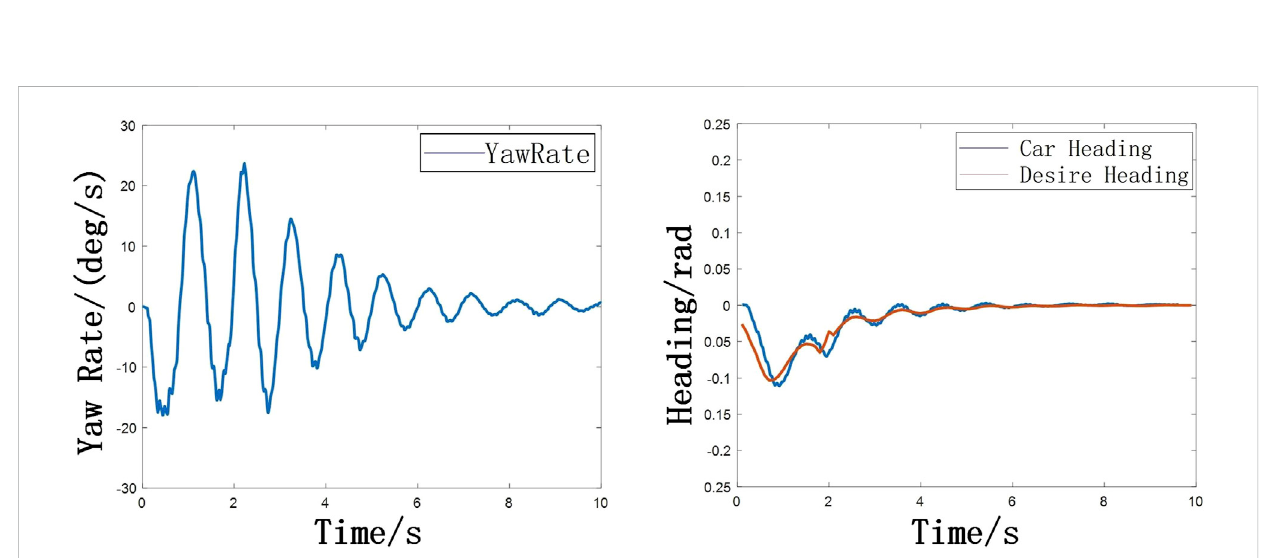
FIGURE 10 (A) Variation of yaw rate with time (B) Variation of heading angle with